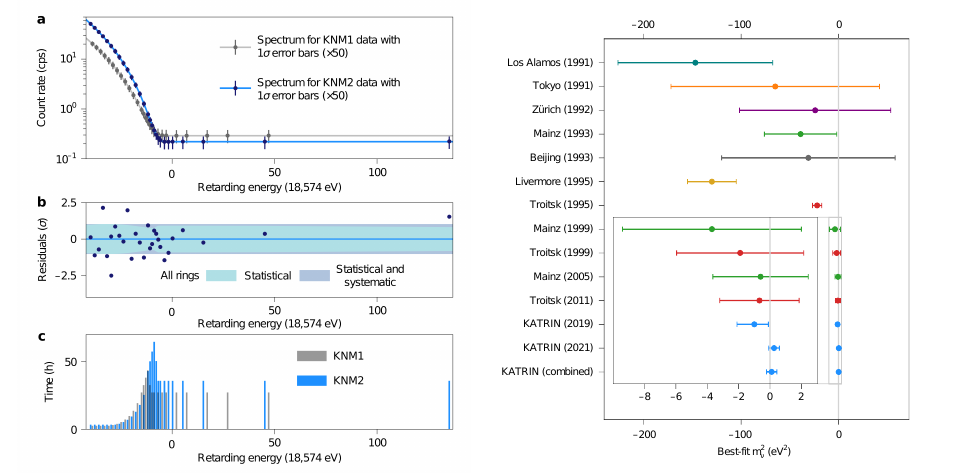
Figure 3. (Right): Measurement rate at each retarding energy for the first two KATRIN campaigns KNM1 and KNM2 [8]. (a) Data points for the count rate over all the detector rings. Error bars rep- resent the statistical uncertainties multiplied by a factor of 50. Best-fit models for each campaign are represented by the colored lines. A reduced background rate, higher signal strength and overall higher statistics can be observed for the second campaign. (b) Normalized residuals for the fit to the data from KNM2. The shaded areas represent the statistical and total uncertainties. (c) Measurement time distri- bution for the two campaigns. (Left): Comparison of KATRIN results for the neutrino mass with past measurements [8]. The error bars represent the combined statistical and systematic